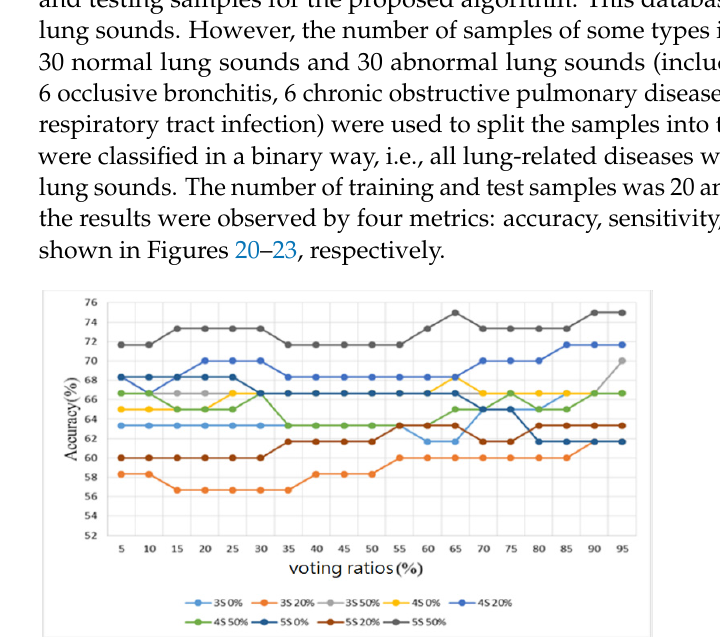
Figure 19. Heart sound classification results: F1 Score. ( a ) Testing samples. ( b ) Noisy samples. Table 4. Sizes of heart sound samples.